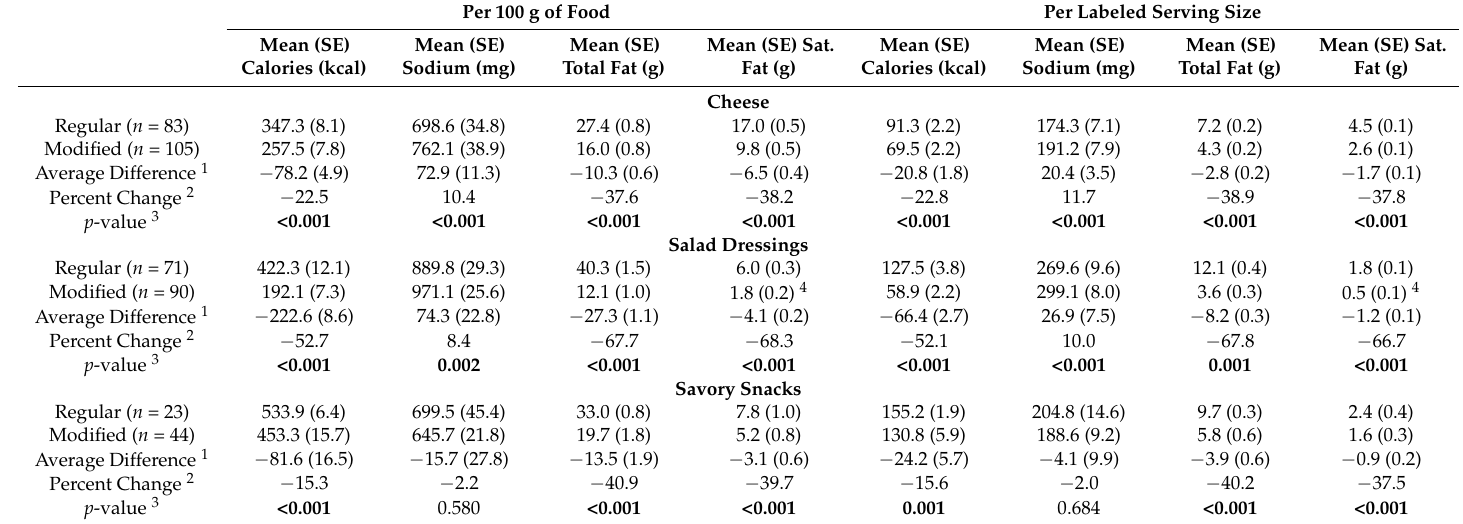
Table 2. Mean calorie, sodium, total fat, and saturated fat by food category for regular and modified